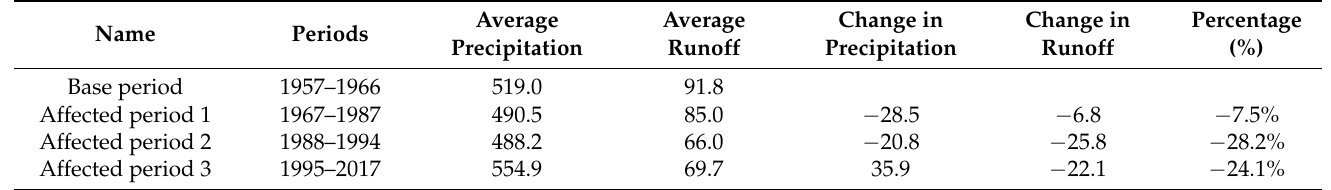
Figure 7. Changes in the annual runoff and precipitation during the period from 1957 to 2017. Table 4. The observed precipitation and runoff in the different